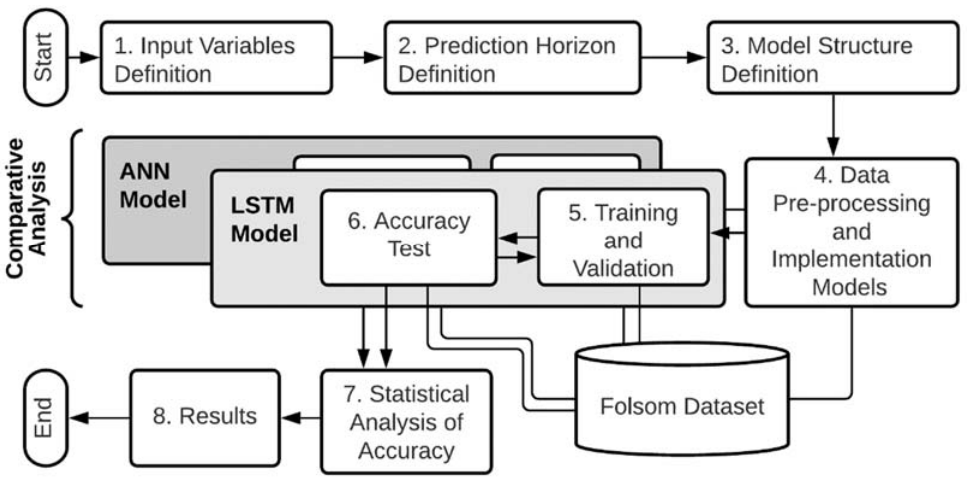
Figure 3. Experimental method execution: components, flow and steps.